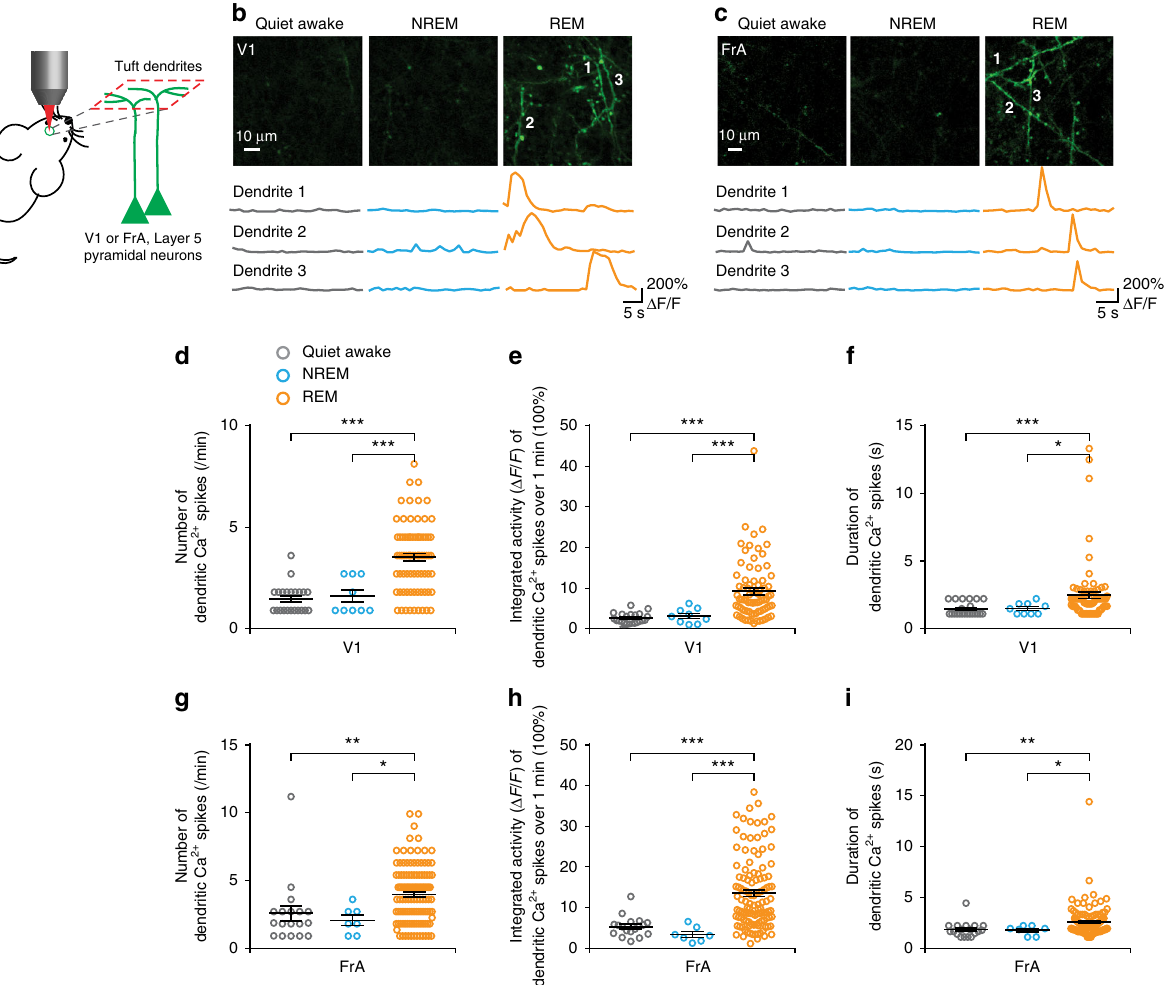
Fig. 5 Dendritic Ca 2 + spikes increase during REM sleep. a Two-photon Ca 2 + imaging of apical tuft dendrites of layer 5 pyramidal neurons in head- restrained mice during quiet awake, NREM sleep, and REM sleep. b , c Ca 2 + imaging of apical tuft dendrites under various states in V1 ( b ) and FrA ( c ). Scale bar, 10 µ m. Ca 2 + fl uorescence traces of three dendrites over 30 s are shown. d , g The number of dendritic Ca 2 + spikes during REM sleep was signi fi cantly higher than that in other brain states in both V1 ( d ) ( n = 4 mice, P < 0.0001 and = 0.0004 for REM sleep vs. quiet awake and NREM sleep, respectively) and FrA ( g ) ( n = 5 mice, P = 0.0019 and = 0.0117 for REM sleep vs. quiet awake and NREM sleep, respectively) (Wilcoxon – Mann – Whitney test, two- sided). e , h The integrated activity of dendritic Ca 2 + spikes during REM sleep was signi fi cantly higher than those during NREM sleep and quiet awake state in both V1 ( e ) ( n = 4 mice, P < 0.0001 and = 0.0003 for REM sleep vs. quiet awake and NREM sleep, respectively) and FrA ( h ) ( n = 5 mice, P < 0.0001